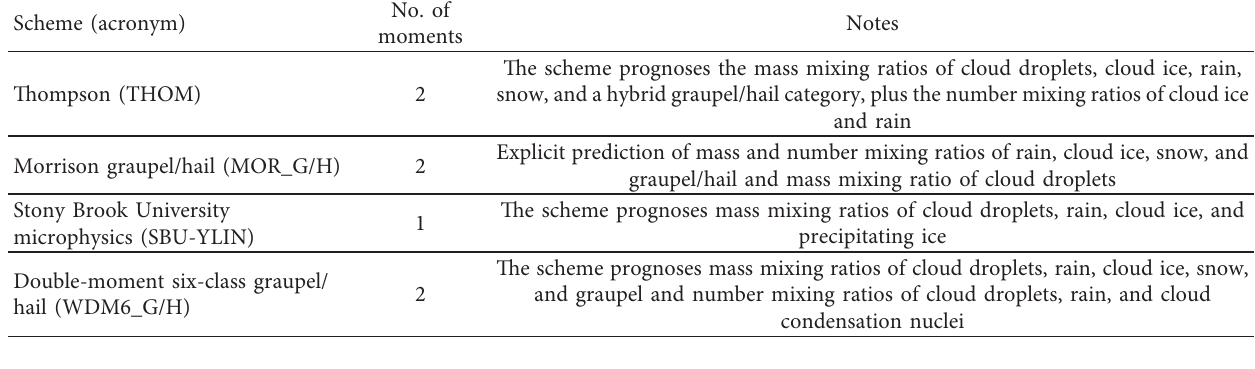
Table 2: Characteristics of the four microphysical schemes used for the WRF simulations.